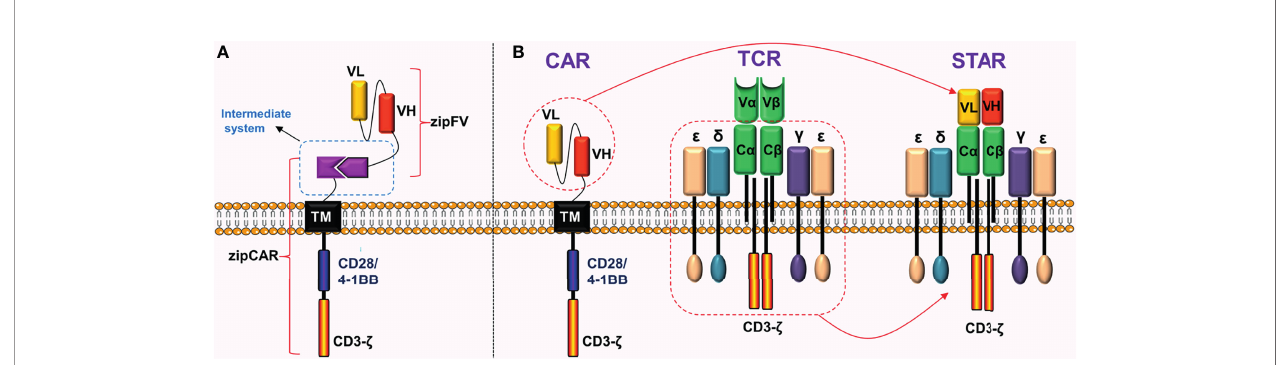
( Figure 10A ). Local administration of activating drugs can better reduce off-target effects for on-switch CAR-T